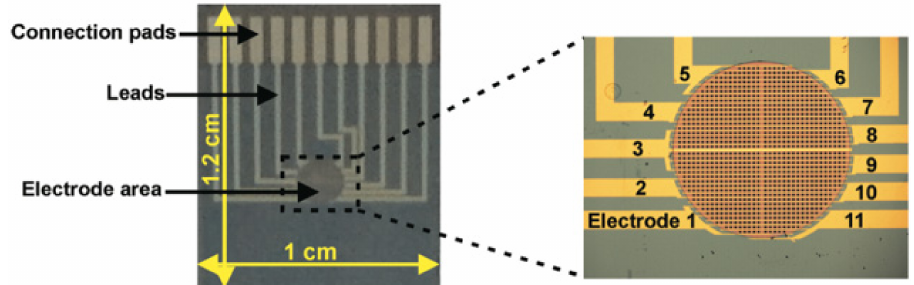
Figure 9. Schematic of 11 microelectrodes fabricated on the surface of Au electrode. Reprinted with permission from reference [47]. Copyright 2010 American Chemical